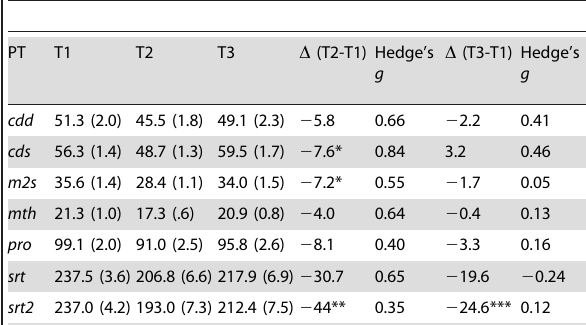
Table 5. Throughput Means (SE) for Concussed Service